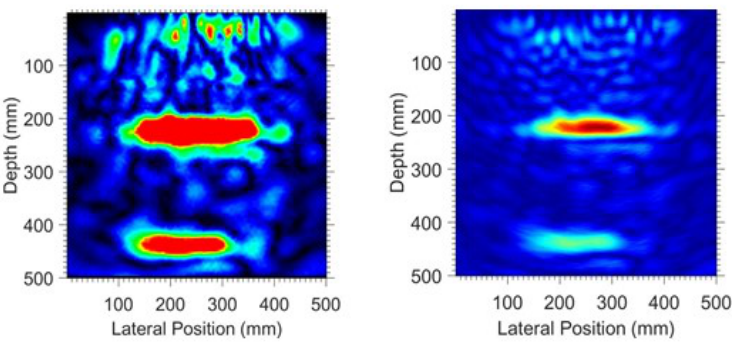
Figure 3. Standard (left) and evaluated (right) images of a TS’